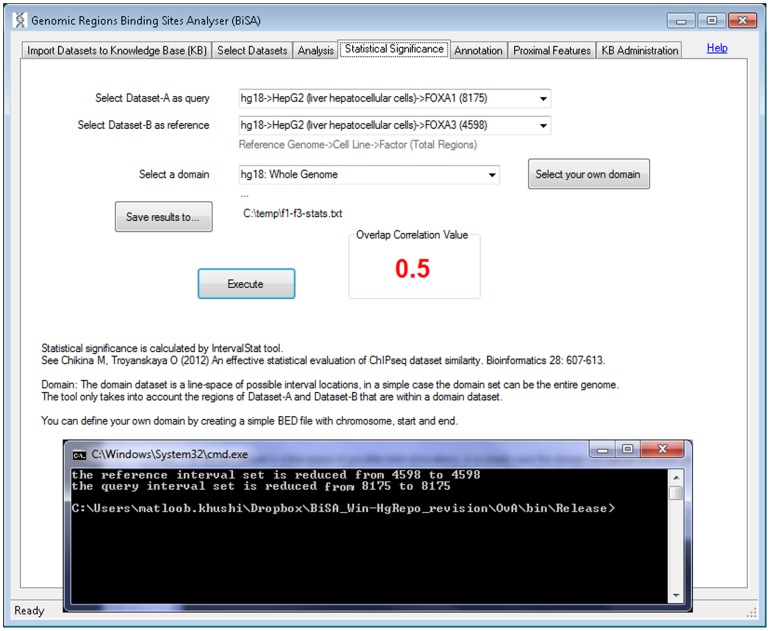
Statistical significance of overlapping regions.The statistical significance tab allows the user to determine the statistical significance of the extent of overlap of two sets of regions. Active datasets are loaded into two dropdown lists and the user selects one dataset as a query and the other one as a reference. Only regions of both datasets that are within the selected domain dataset are included in the calculation. Clicking the Execute button calls up a command-line window and executes the IntervalStat tool. The command-line window stays open to display the messages from the tool. When the terminal window is closed BiSA calculates Overlap Correlation Value of the two datasets.